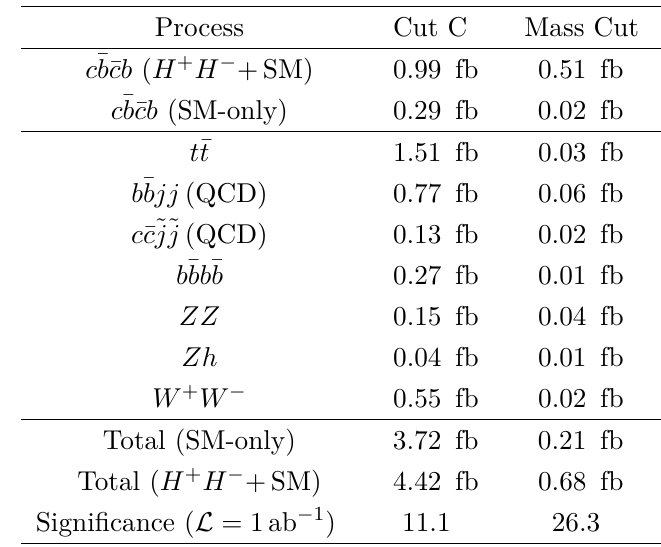
Table 2 . Same as table 1, but after Cut C and Mass Cut. See text for more details.